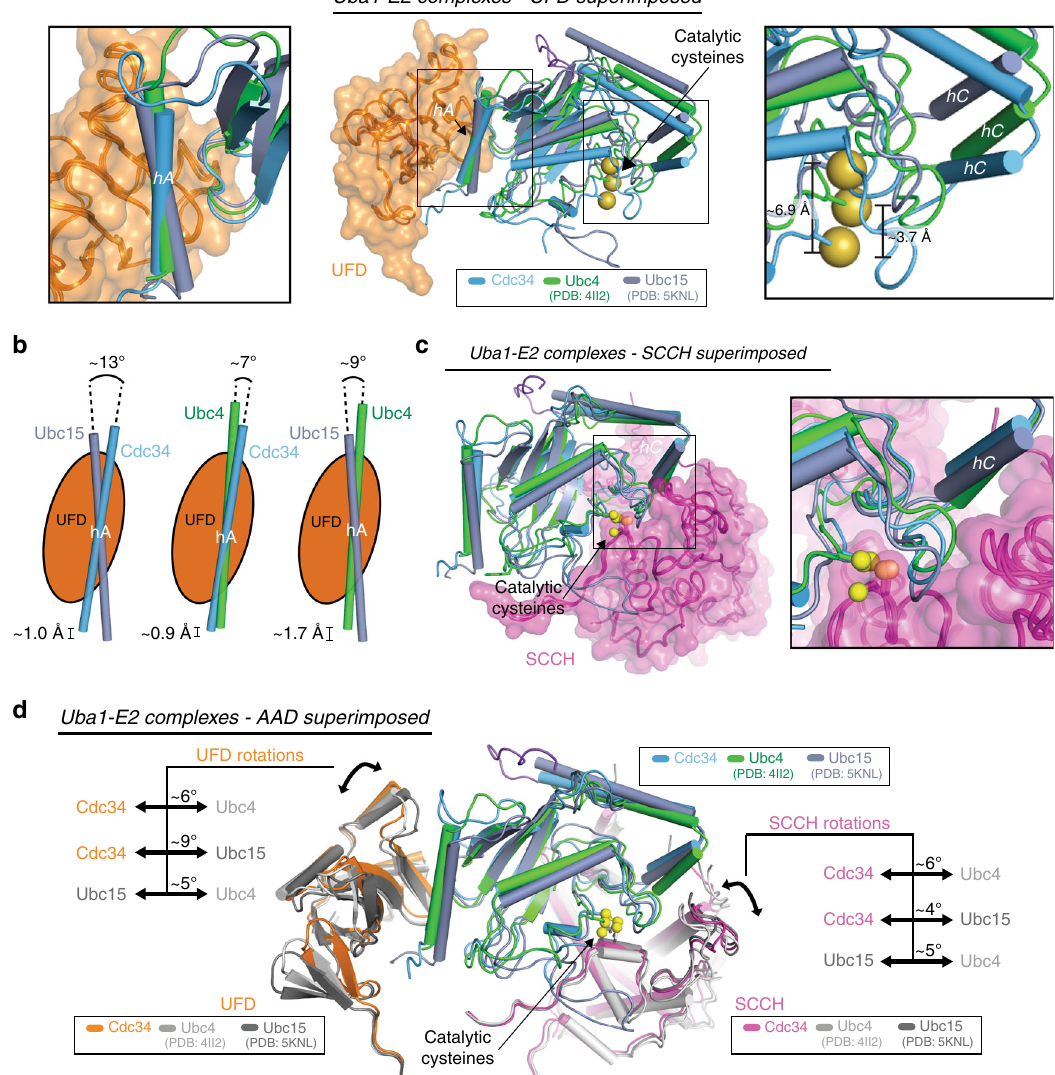
Fig. 3 Distinct Uba1 architectures accommodate different E2-binding modes. a Middle , superimposition of Uba1-Cdc34, Uba1-Ubc4 (PDB:4II2), and Uba1- Ubc15 (PDB:5KNL) complexes by the UFD. Cdc34 is colored blue, Ubc4 is green, Ubc15 is gray. hA/UFD interface and catalytic cysteine positioning are highlighted by black boxes. Left , zoomed in, head-on view of E2 hA binding to Uba1 UFD. Right , zoomed in view of catalytic cysteine positions. b Cartoon schematic of difference in angle of hA bound to Uba1 for each E2 pair, as in a . c Left , superimposition of Uba1 – E2 complexes by the SCCH with the E2/ SCCH interface highlighted by a black box. Right , zoomed in view of the E2/SCCH interface. d Superimposition of Uba1 – E2 complexes by the AAD with the E2, UFD, and SCCH shown. Relative differences in rotation for the UFD ( left ) and SCCH ( right ) are indicated by